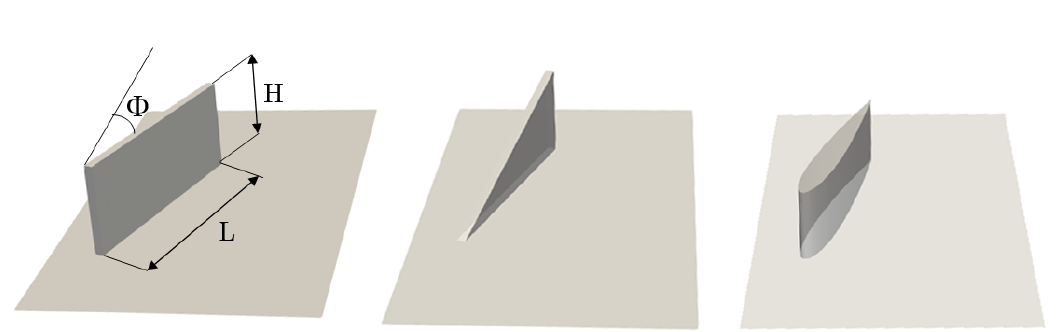
Figure 1. VG geometries analyzed, Rectangular VG, Triangular VG, Symmetrical VG NACA0012 in